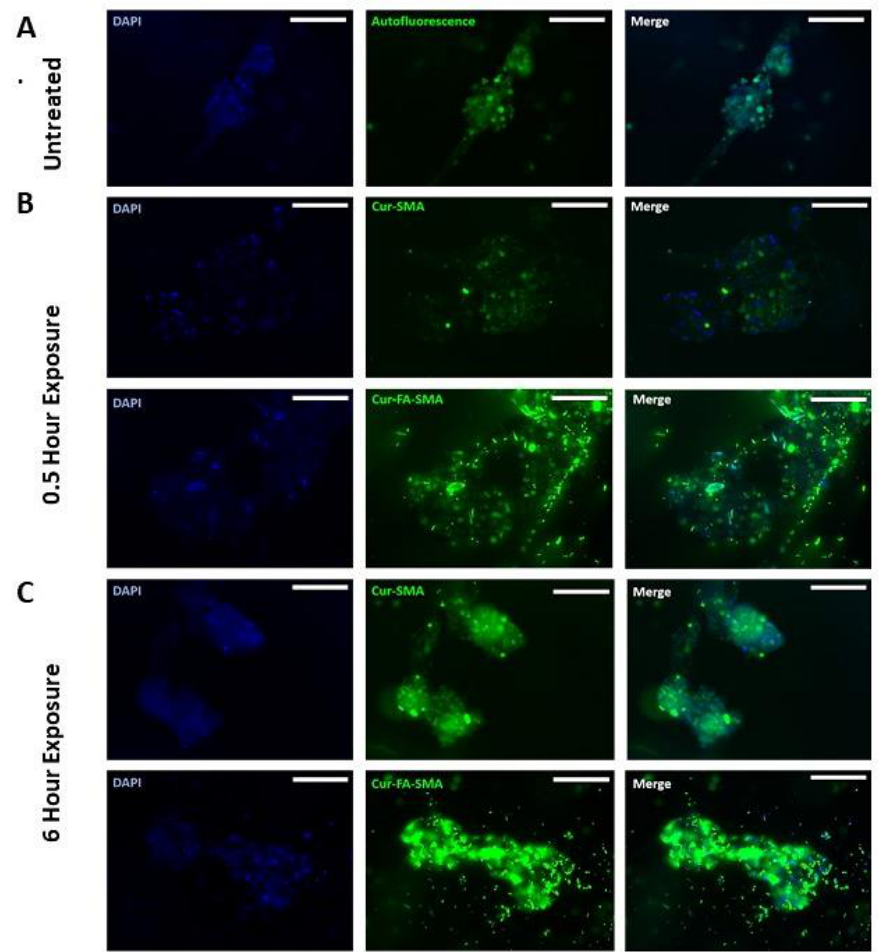
Figure 5. Fluorescent images at 200 × objective demonstrating the variation between tumour spheroid uptake of curcumin loaded SMA and FA-DABA-SMA after 0.5 h and 6 h. ( A ) Untreated MDA-MB-231 breast cancer cell MCTS. ( B ) 3 µ M Curcumin loaded SMA, and 3 µ M curcumin-loaded FA-DABA-SMA was added to MDA-MB-231 spheroids for 0.5 h. ( C ) 3 µ M Curcumin loaded SMA, and 3 µ M curcumin-loaded FA-DABA-SMA was added to MDA-MB-231 spheroids for 6 h. The image scale bar represents 100 µ m. Abbreviations : SMA, poly (styrene- alt -maleic anhydride); FA, folic acid; DABA, 2,4-diaminobutyric acid; Cur, curcumin; Auto, auto-fluorescence.